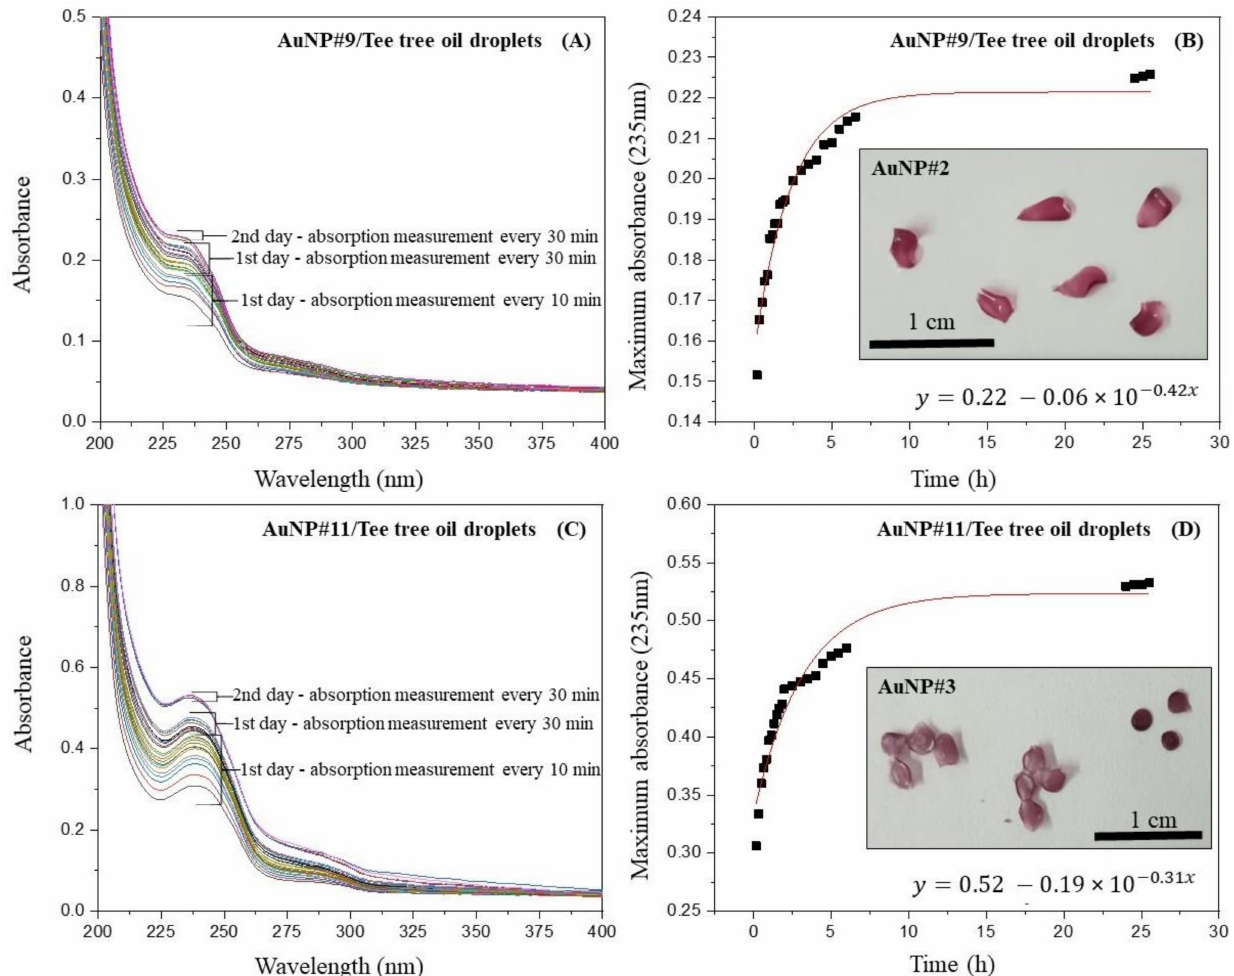
Figure 5. ( A ) UV-vis spectra of the release process of tea tree oil from AuNP#9droplets; ( B ) absorbance maxima at 235 nm of the release process from AuNP#9-droplets; ( C ) UV-vis spectra of the release process of tea tree oil from AuNP#11-droplets; and ( D ) absorbance maxima at 235 nm of the release process from AuNP#11-droplets.